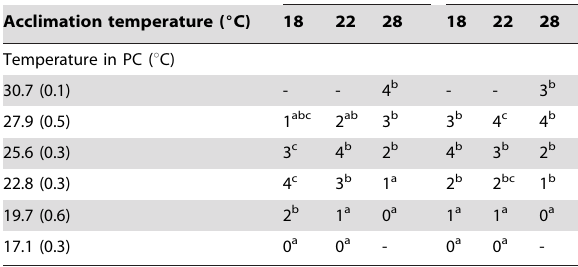
Table 2. Ranking of the use of the temperature zones in the preference chamber (PC) by Dover sole acclimated to 18, 22 and 28 u C, directly after installation of the temperature gradient (acute preference) and 24 h thereafter (24 h